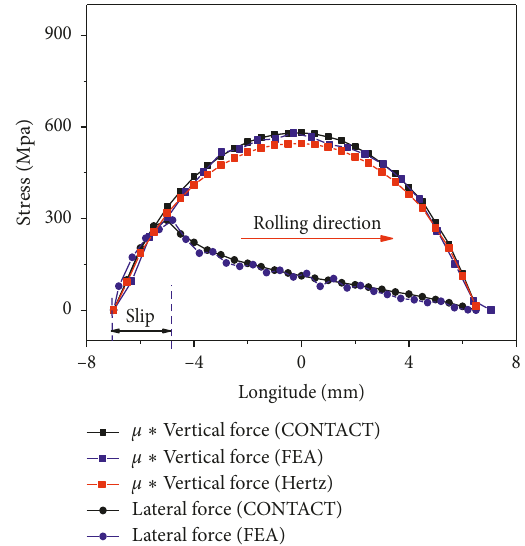
Figure 9: Verification of contact